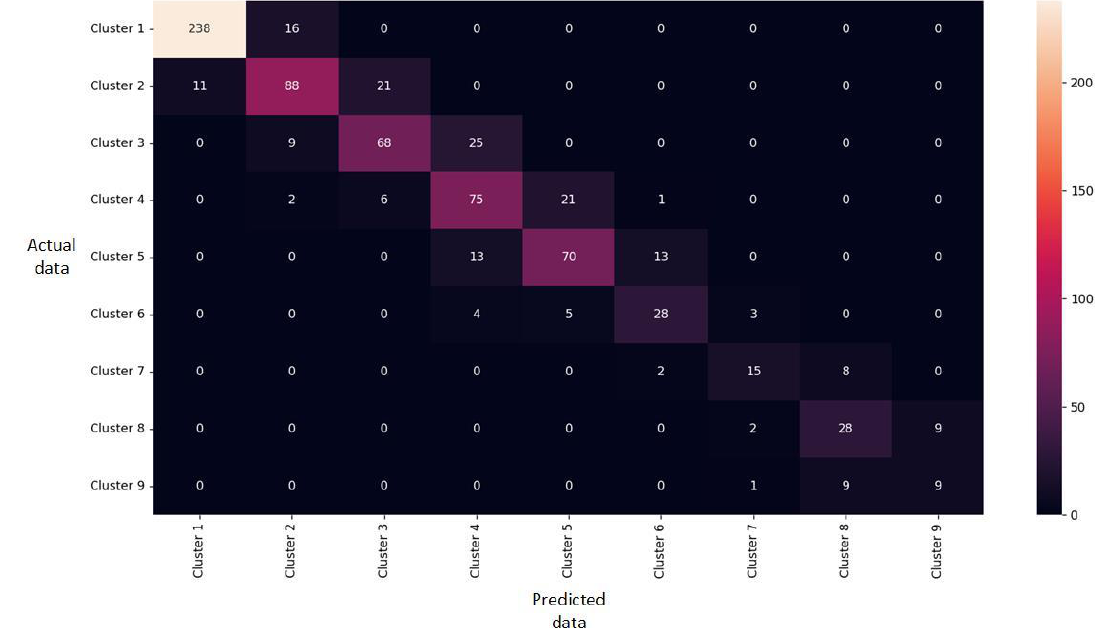
Figure 8. The confusion matrix of the proposed model. Table 2. Precision, recall, and F1-score of the proposed model and counterpart models. Model Precision Recall F1-Score LSTM 0.65 0.64